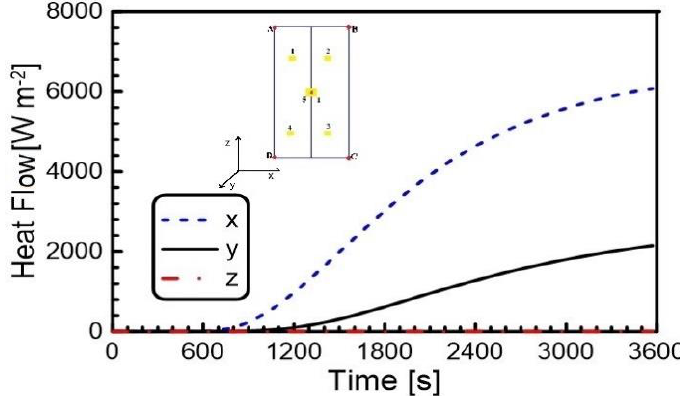
Figure 6. Thermal measurement point 1: deconvolution of the heat flow as a function of time along the Cartesian directions (x, y, z).